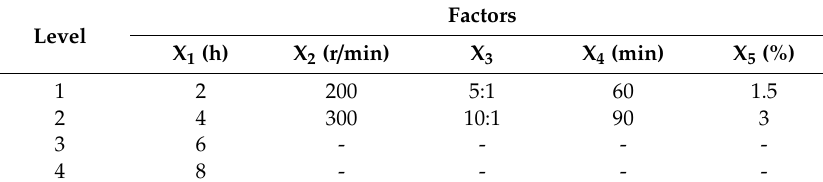
Table 2. Factors in the orthogonal test and their levels.